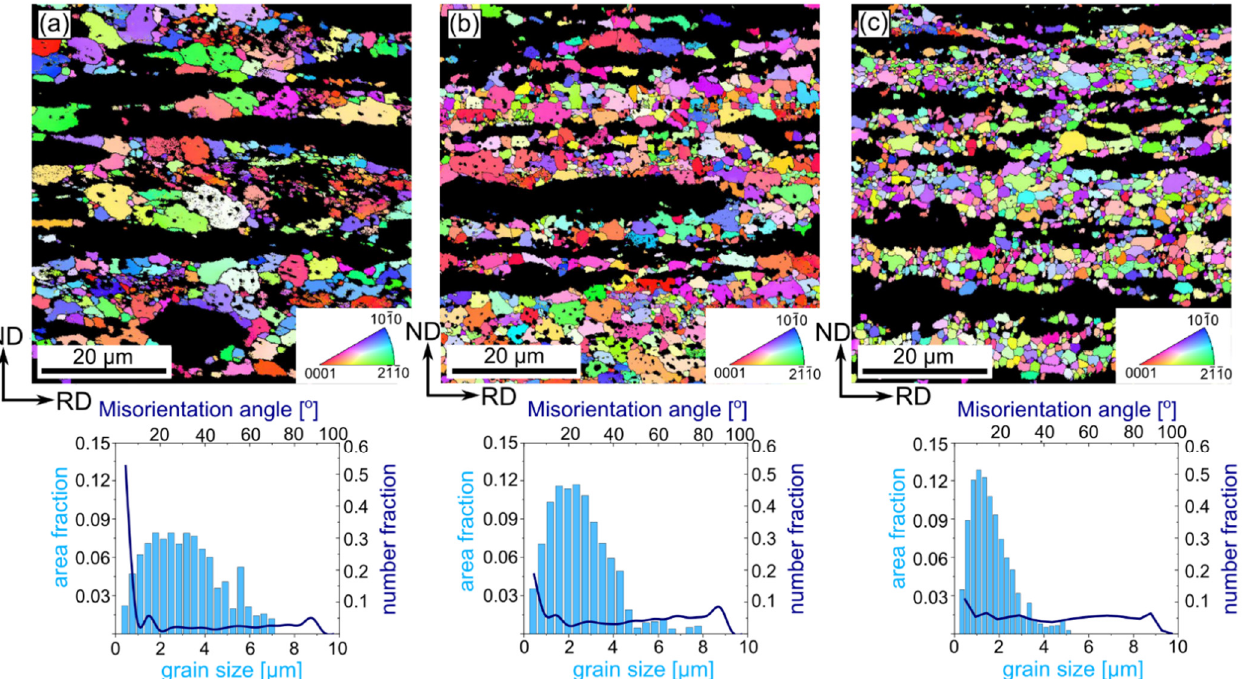
Figure 5. Orientation maps with the corresponding distribution of grain size and misorientation angle of cold-rolled Zn-5Cu alloy with the reduction rate of ( a ) 50%, ( b ) 75% and ( c ) 90%. Dark areas related to the second phase and were excluded form from the analysis. HAGBs and LAGBs were marked with black and yellow colors, respectively. The orientation maps are color-coded based on the IPF triangle depicted in the right corner with the respect to the RD.